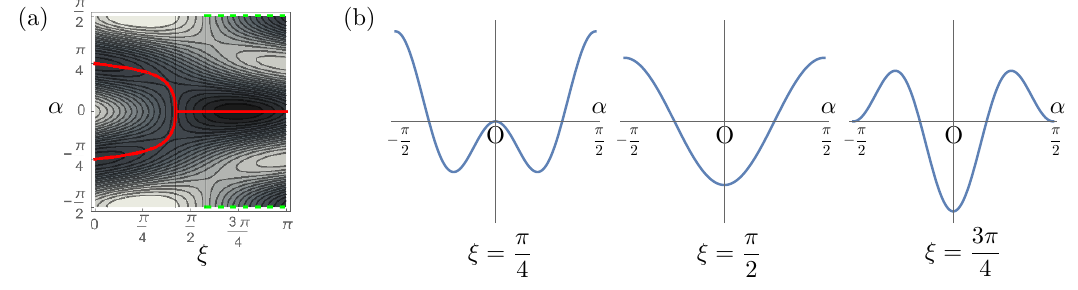
Figure 12 . (a) Contour plot of the U(1) color is, the lower the potential is. Bottom of the potential and the local minimum are indicated by thick-dashed and thick-solid curves, respectively. (b) Typical slices of V (cid:24) ( (cid:11) ) for (cid:11) (cid:24) = k(cid:25) ( k = 1 ; 2 ; 3) are 4